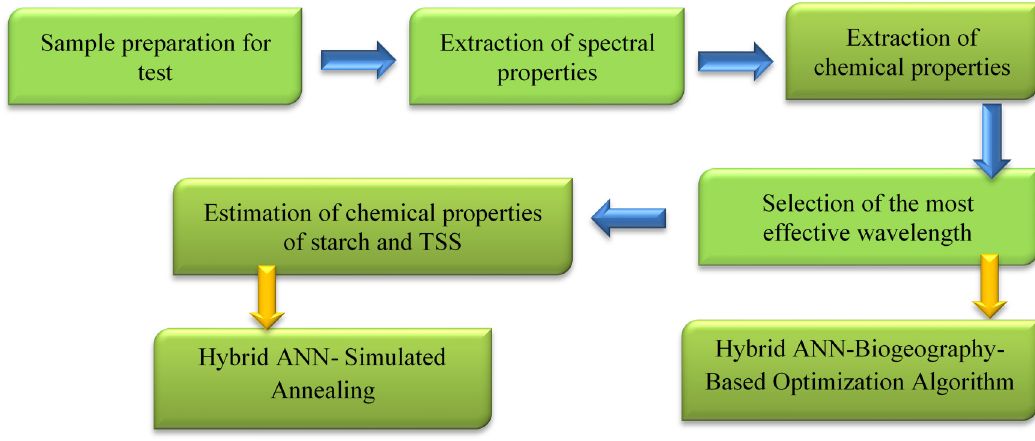
Figure 1. Flowcharts of different training steps of the proposed method for non-destructive estimation of starch and total soluble solids (TSS) properties of Fuji apple